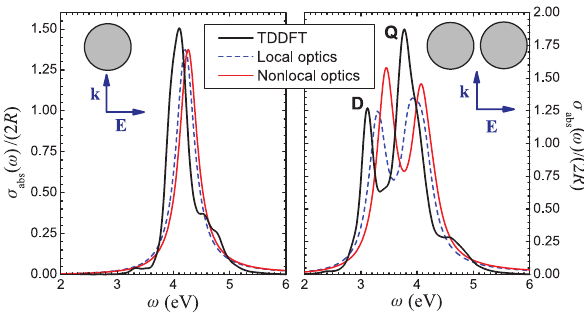
Figure 2: Left panel: Optical absorption spectrum of a sodium nanowire ( R = 2 nm). Right panel: Optical absorption of a sodium nanowire dimer ( R = 2 nm, d = 0.5 nm). Thick black line: TDDFT; thin blue line: non-local optics; dashed red line: local optics. Both clas- sical calculations have been performed with a damping frequency γ = 0.38 eV. Figure adapted from Ref.